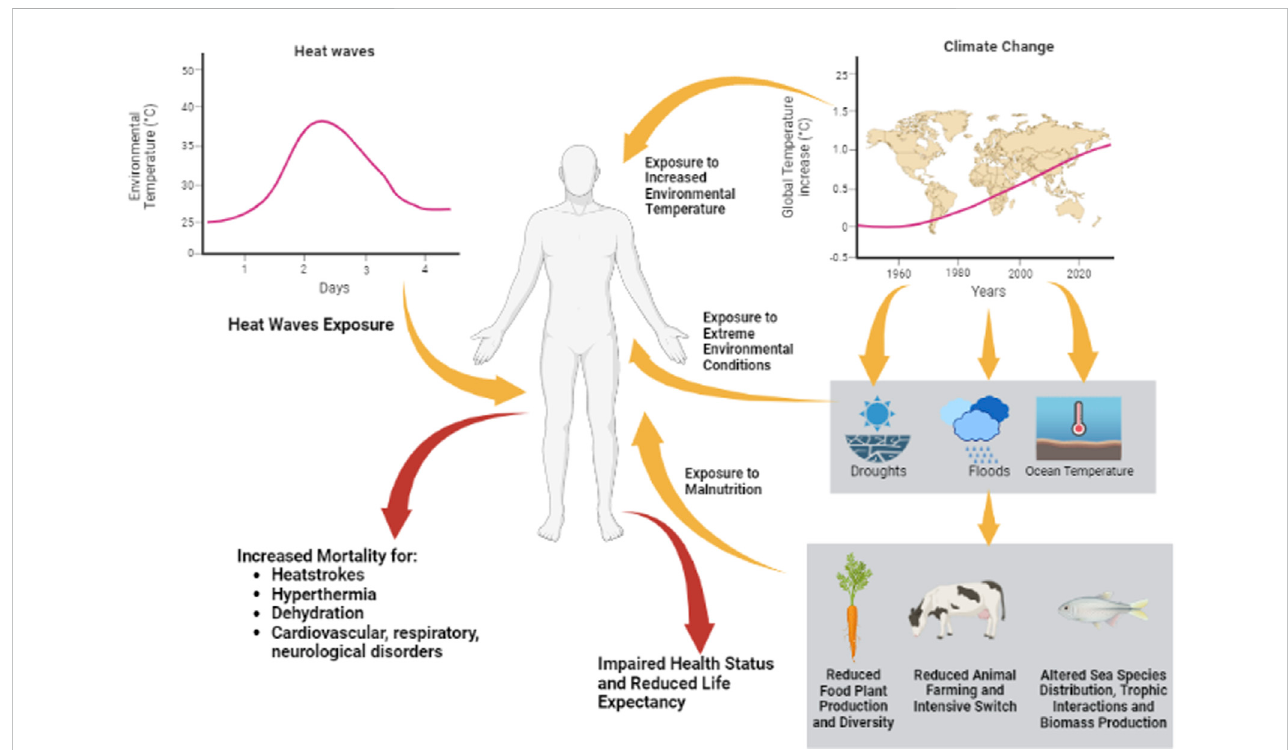
FIGURE 2 Heatchallengescanbesummarizedas heat waves,generallyconsideredas temperaturesthat are eitherunusuallyhighcomparedto characteristiclocal environments,and/orclimatechangethroughtheincreaseinaverageenvironmentaltemperaturecomparedtothe1850 – 1900baseline.The fi rsthaveshort- term effects on human health, increasing the risk of mortality for heat strokes, hyperthermia, dehydration, and cardiovascular, respiratory, or neurological disorders. The second has more complex effects on the health status and life expectancy of humans, involving increased exposure to extreme environmental conditions and exposure to malnutrition for impairment of the